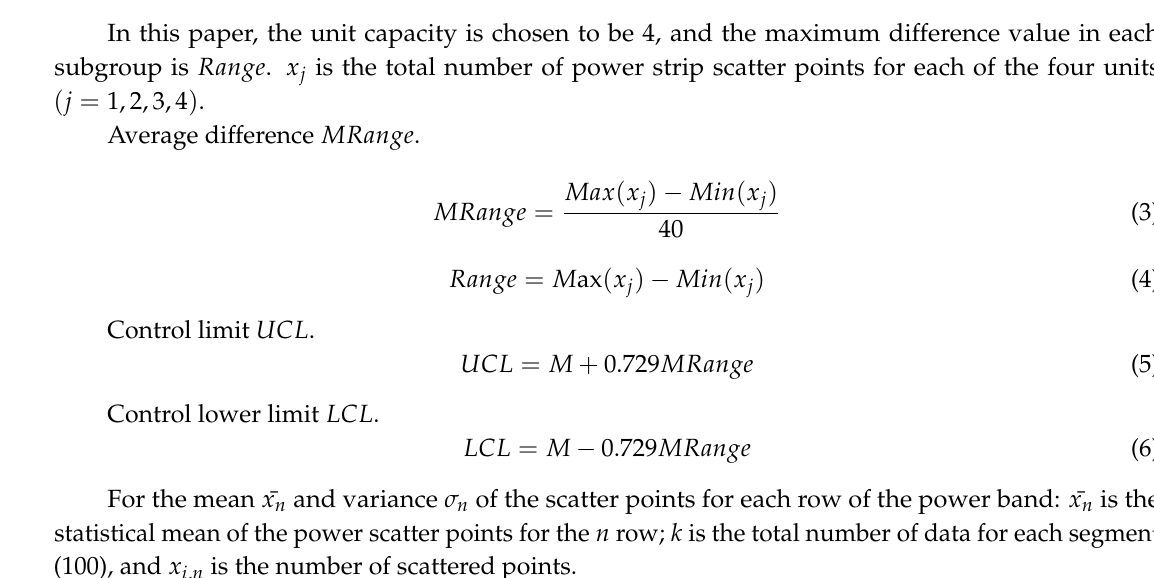
Figure 2. Wind farm unit distribution satellite